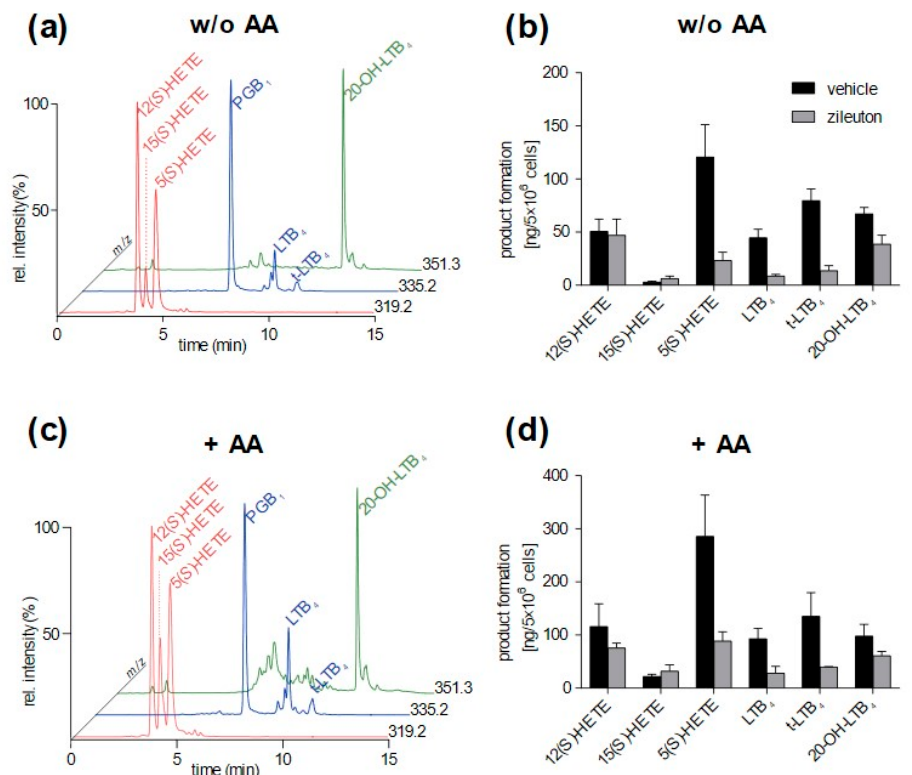
Figure 5. Quantitative analysis of selected oxylipins formed in neutrophils. Cells were preincubated (10 min) by zileuton (3 µM) or vehicle (0.1% v / v ) followed by 10 min stimulation with 2.5 µM A23187 without AA ( a , b ) or with 5 µM AA ( c , d ). Representative SIM chromatograms are shown in ( a , c ) and ( b , d ) presenting quantitative data of analyzed oxylipins formed via 5-, 12-, and 15-LOX pathways. Values are expressed as mean + SEM ( n = 3).